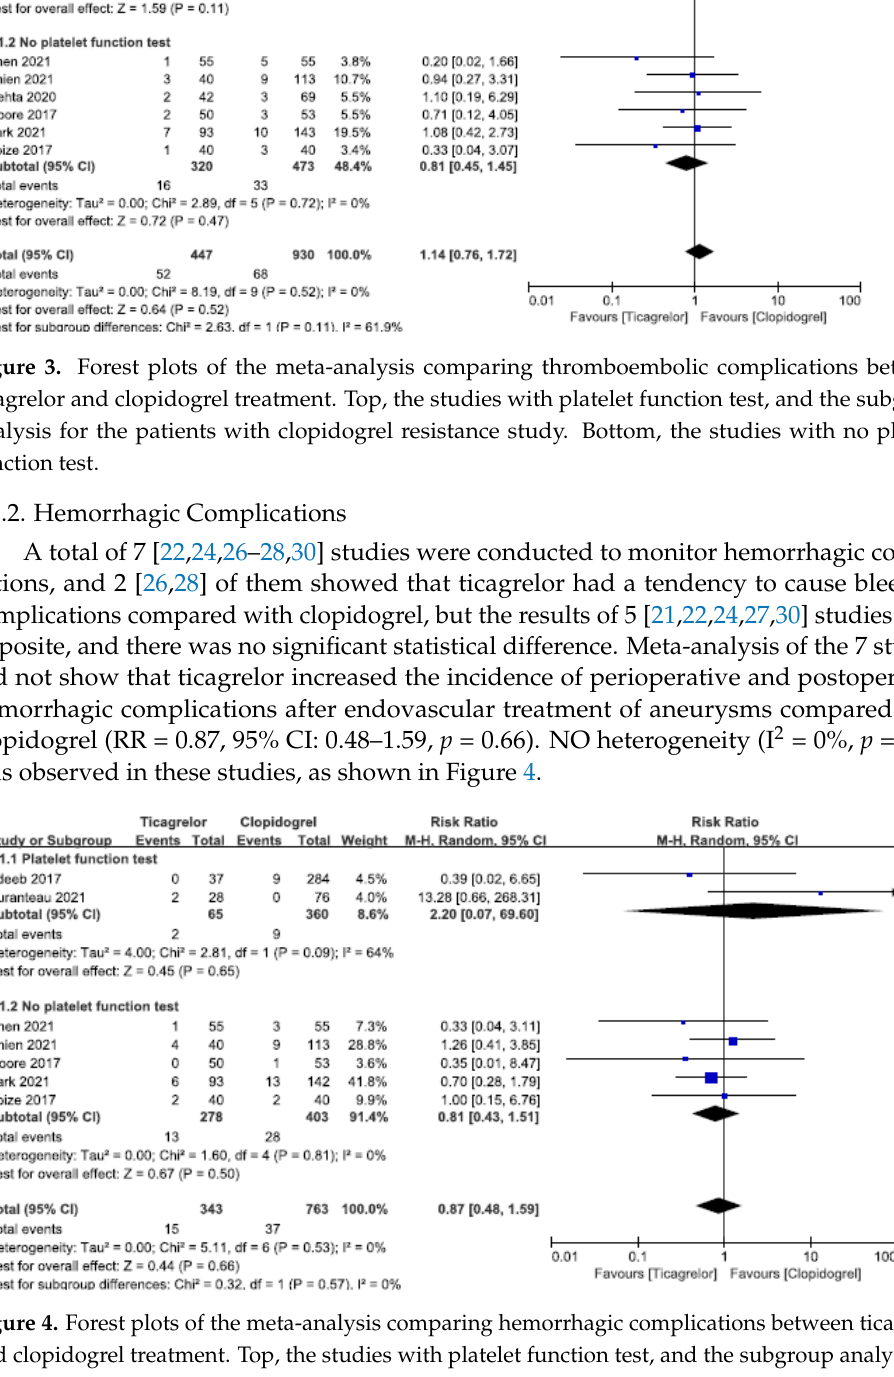
Figure 3. Forest plots of the meta-analysis comparing thromboembolic complications between ti- cagrelor and clopidogrel treatment. Top, the studies with platelet function test, and the subgroup analysis for the patients with clopidogrel resistance study. Bottom, the studies with no platelet func- tion test.